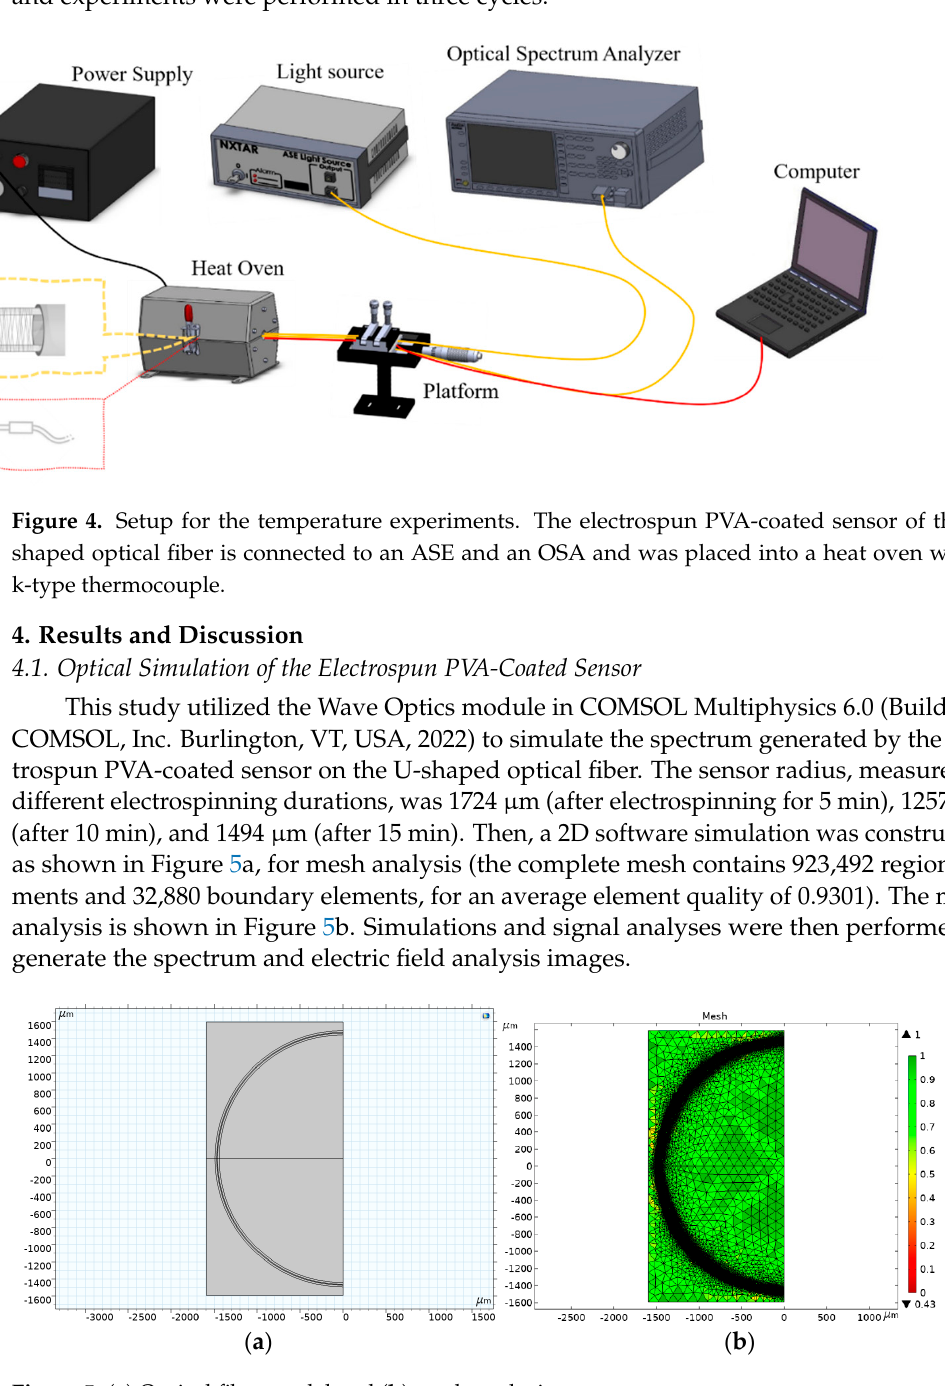
Figure 3. Electrospun U-shaped optical fiber products formed under different electrospinning du- rations ( a ) 5 min, diameter = 3448 μ m; ( b ) 10 min, diameter = 2514 μ m; ( c ) 15 min, diameter = 2988 μ m; ( d ) optical microscope (OM) image for the bar U-shaped fiber; ( e ) SEM im-age for electrospun fibers; ( f ) SEM image to show the fiber morphology after the electrospun PVA fibers.